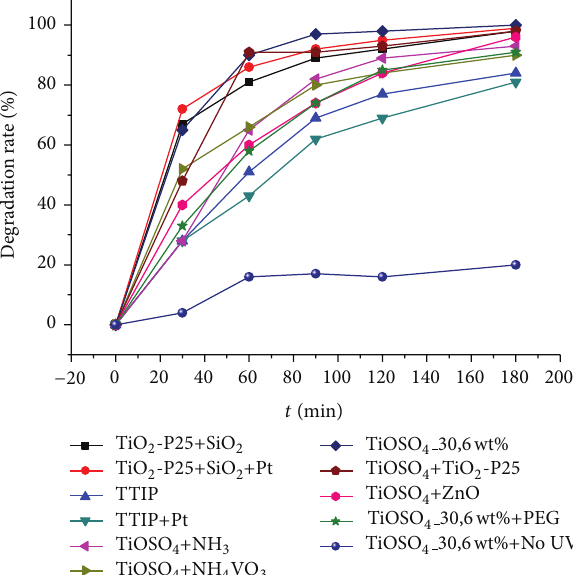
Figure 11: Degradation kinetic of MB using diverse immobilized catalyst under UV light. MB initial concentration: 14mg/L, UV radiation 𝜆 > 280 nm–420 nm, recirculating reactor open to air, absorption at 665 nm and immobilized catalysts.